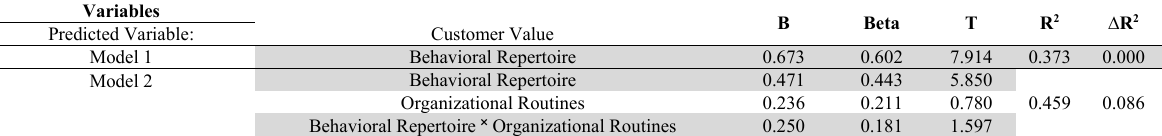
The results of Hierarchical Regression Analysis of the moderating effect of organizational routines on the relationship between behavioral repertoire and Customer Value